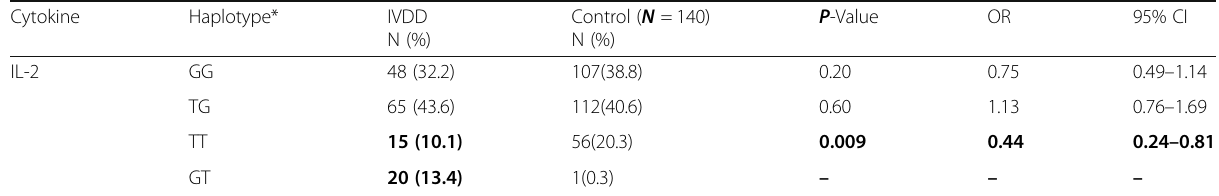
Table 2 The frequencies of IL-2 haplotypes in IVDD patients and healthy controls Cytokine